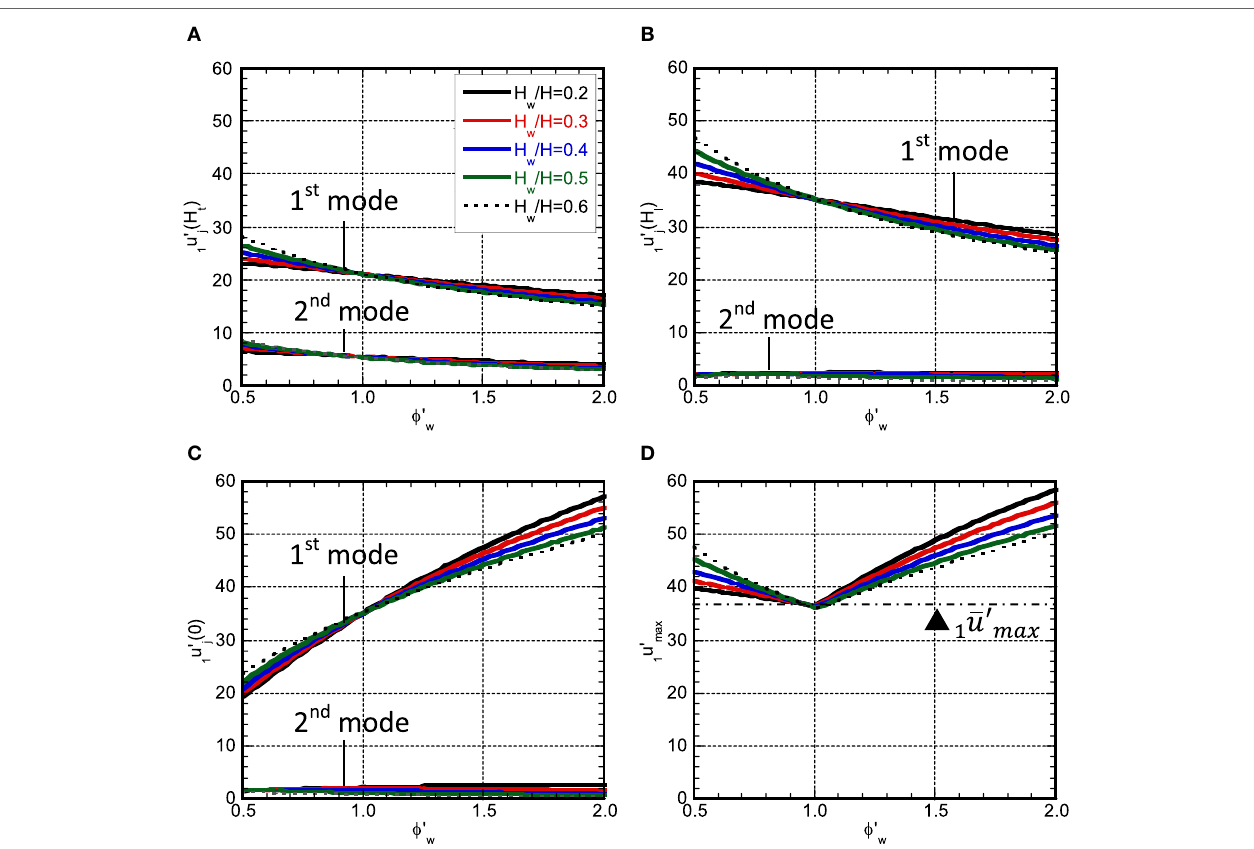
FIGURE 7 | Maximum story drift angle for lowest-mode resonance pulse: (A) 1 u ′ j ( H t ) , (B) 1 u ′ j ( H l ) , (C) 1 u ′ j ( 0 ) , and (D) 1 u ′ max .